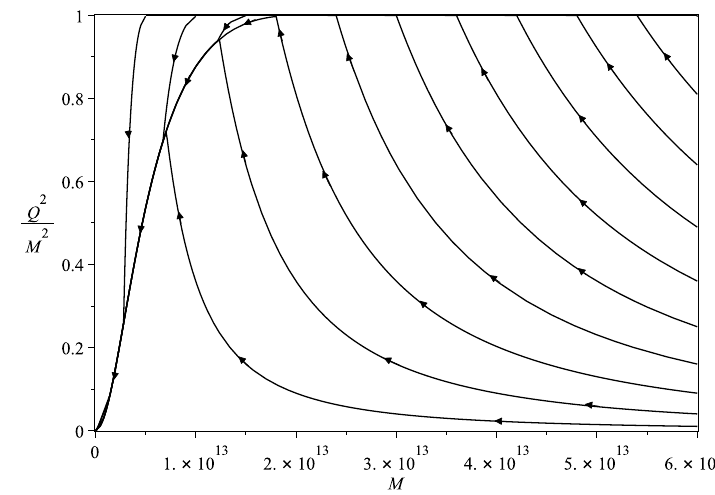
Figure 1 . The evolution of asymptotically (cid:13)at Reissner-Nordstr(cid:127)om black holes under Hawking evaporation with Hiscock-Weems model. Each diagram in this point corresponds to a speci(cid:12)c mass and charge. Given an initial condition, it will evolve by following the arrows. A black hole with su(cid:14)ciently large charge-to-mass ratio simply discharges towards the Schwarzschild limit: this is the \charge dissipation regime". On the other hand, a black hole starting with relatively small charge- to-mass ratio will lose its mass faster than losing charge, and thus Q=M increases: this is the \mass dissipation regime". These curves eventually hit the attractor and (cid:13)ow towards Schwarzschild limit. The model breaks down for su(cid:14)ciently small black holes ( M . Q 0 ). Black holes that are too